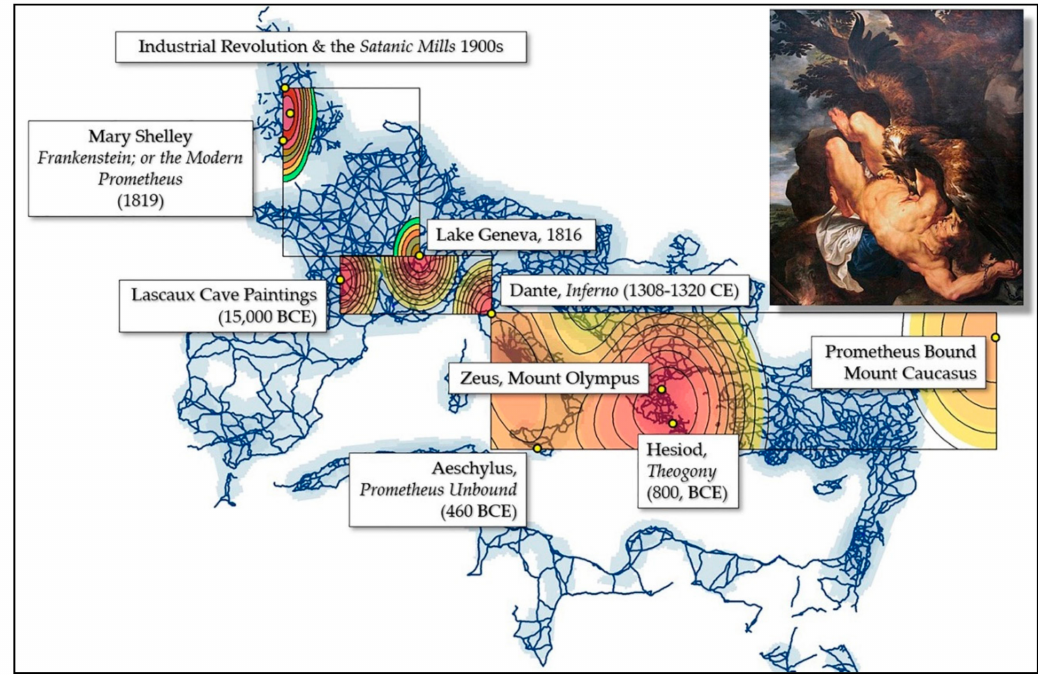
Figure 1. European Literary and Historical Montage Mapping. The Morphology of the Promethean Landscape and Roman Imperial Road Network. Image: Peter Paul Reubens, Prometheus Bound , 1618 (Wikicommons). Map by Charles